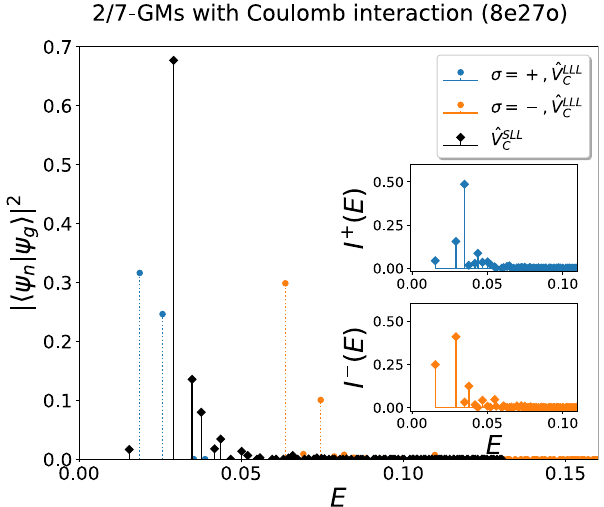
Fig. 5 | Spectral functions of the Jain state at ν =2/7 with 8 electrons with respect to the Coulomb interaction in the LLL ^ V LLL C and the second LL (SLL) ^ V SLL C . In the main plot, the chiralities of the two GMs denoted as σ =+(blue) or − (orange). Thus, the GM with respect to ^ V SLL C (black stemsin the main fi gure)can be further resolved bytaking the overlap with ∣ ψ σ g i as thesubplotsshow,fromwhichonecanclearlyobservethatsomeoftheeigenstates can be regarded as two GMs with opposite chiralities at almost the same energy. Source data are provided as a Source Data fi